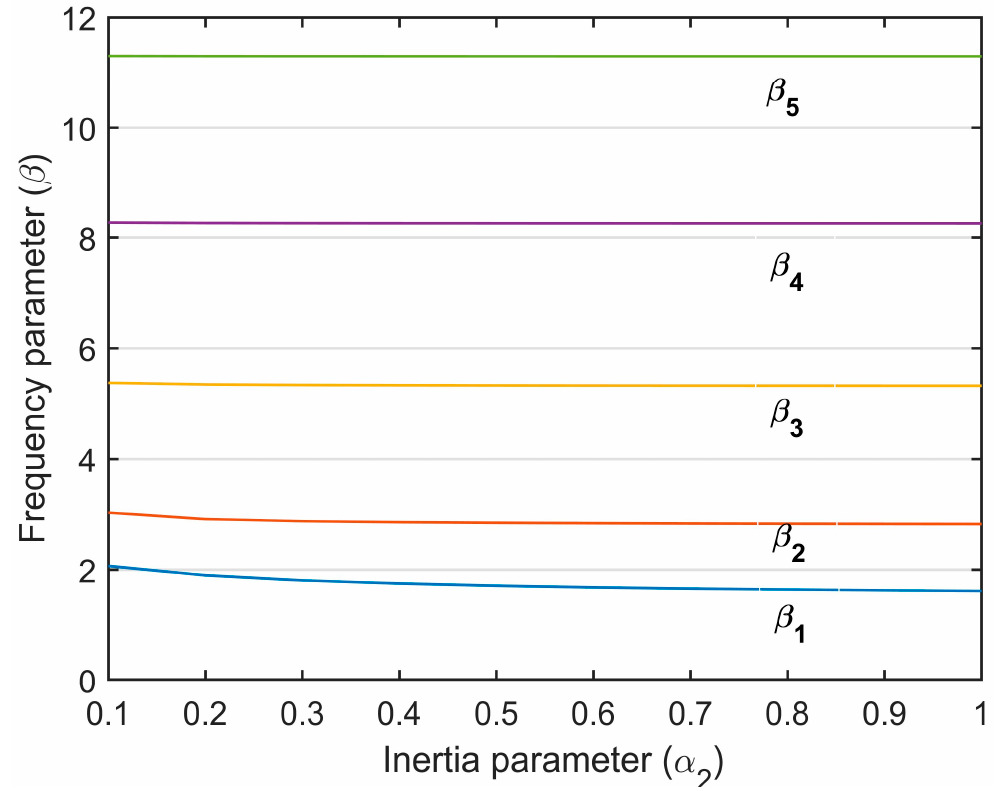
Figure 2. Variation of frequency parameter ( β ) depending on the inertia parameter ( α 2 ) .